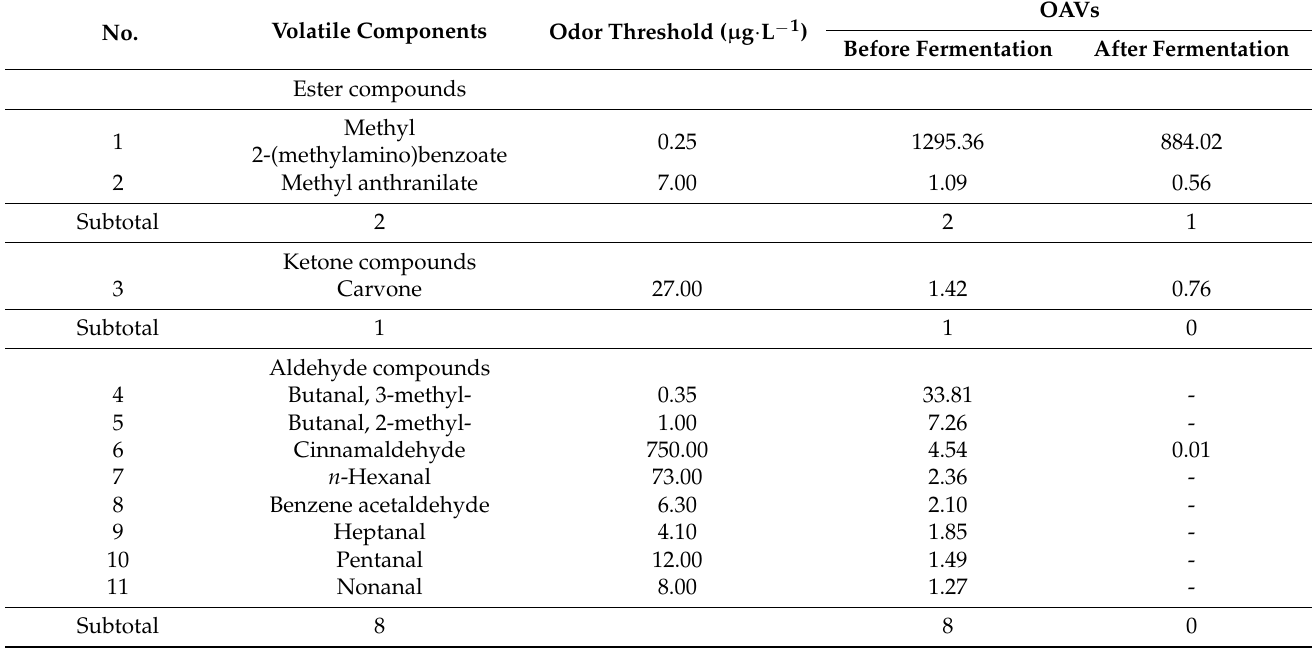
Table 2. Key flavor substances and their OAV values of SHLE before and after fermentation.